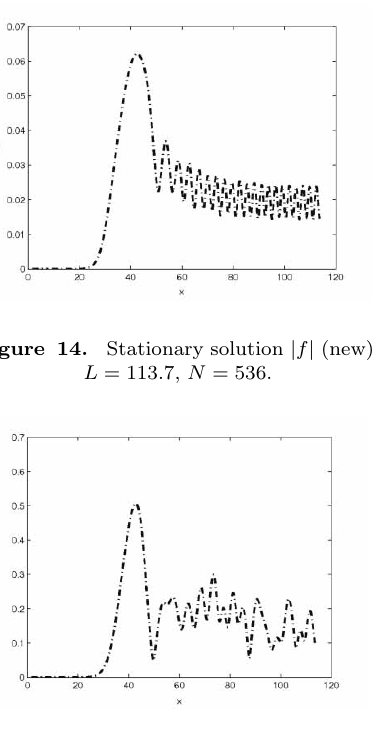
Figure 17. Stationary solution | f | (old), L = 113 . 7, N =